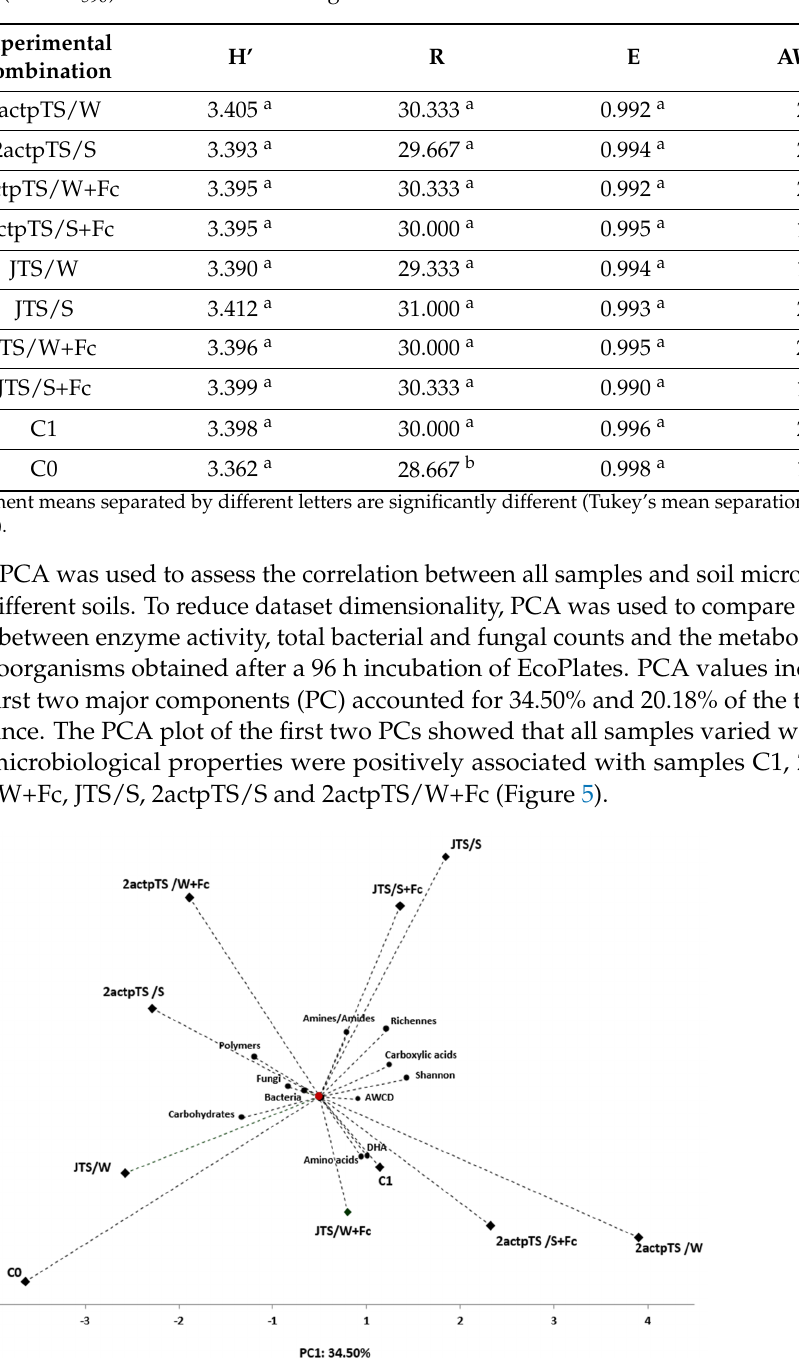
Table 4. Changes in microorganisms metabolic diversity in soils as evaluated by: Shannon’s general diversity index (H’), substrate richness (R), substrate evenness (E) and average well-color develop- ment (AWCD 590 ) obtained in the Biolog EcoPlates incubated for 96 h.